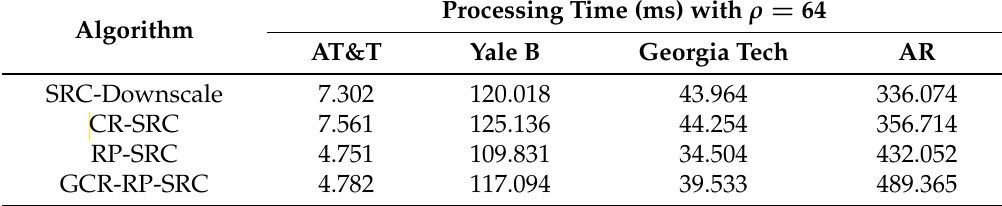
Table 3. Processing Time Simulation